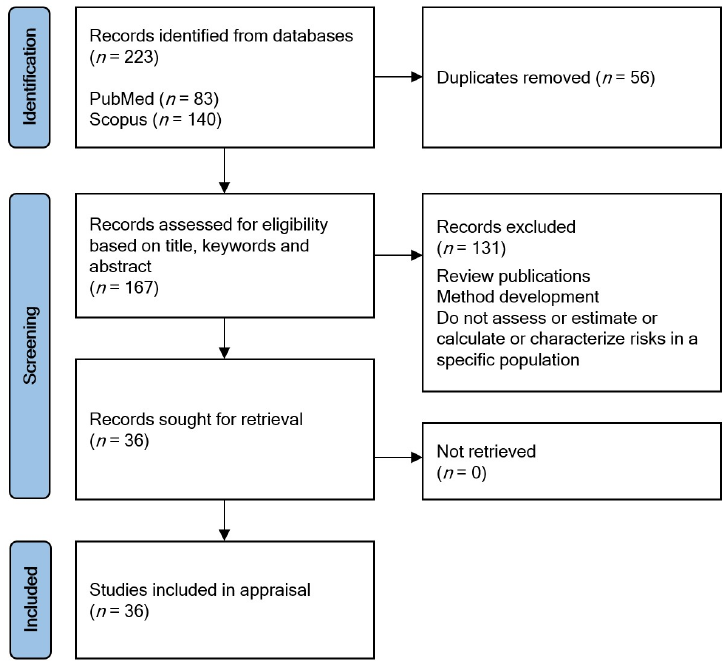
Figure 2. PRISMA flow diagram.